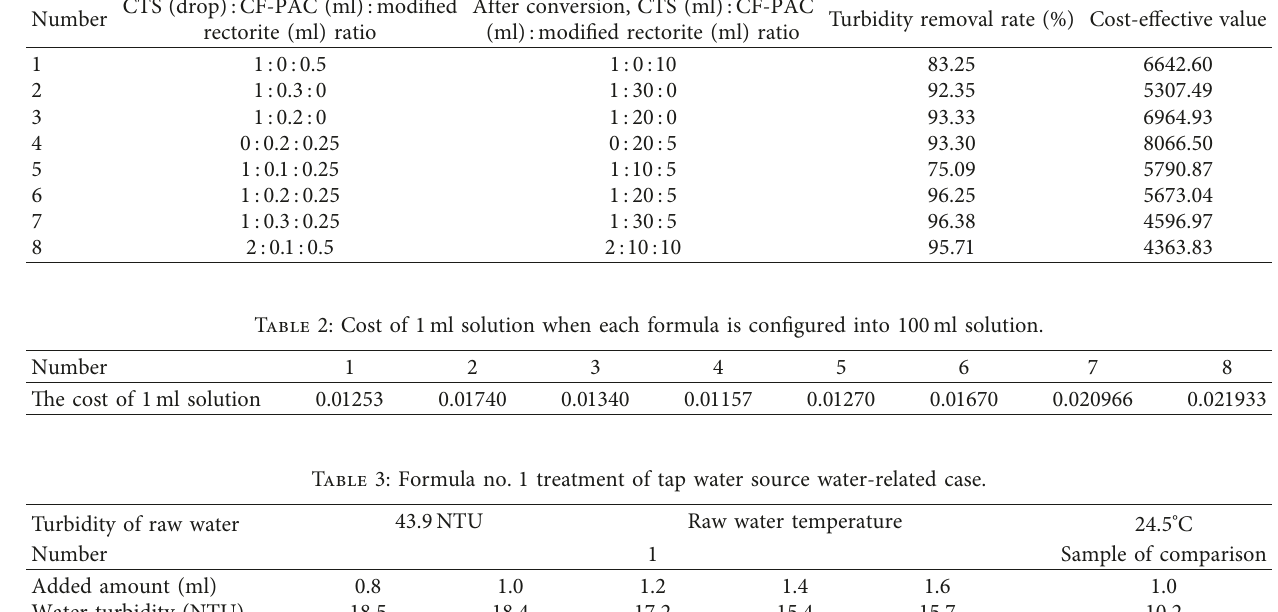
Table 1: The correlation of the most cost-effective formulations in each of the composite schemes. CTS (drop) :CF-PAC (ml): modified After conversion, CTS (ml): CF-PAC Number rectorite (ml) ratio